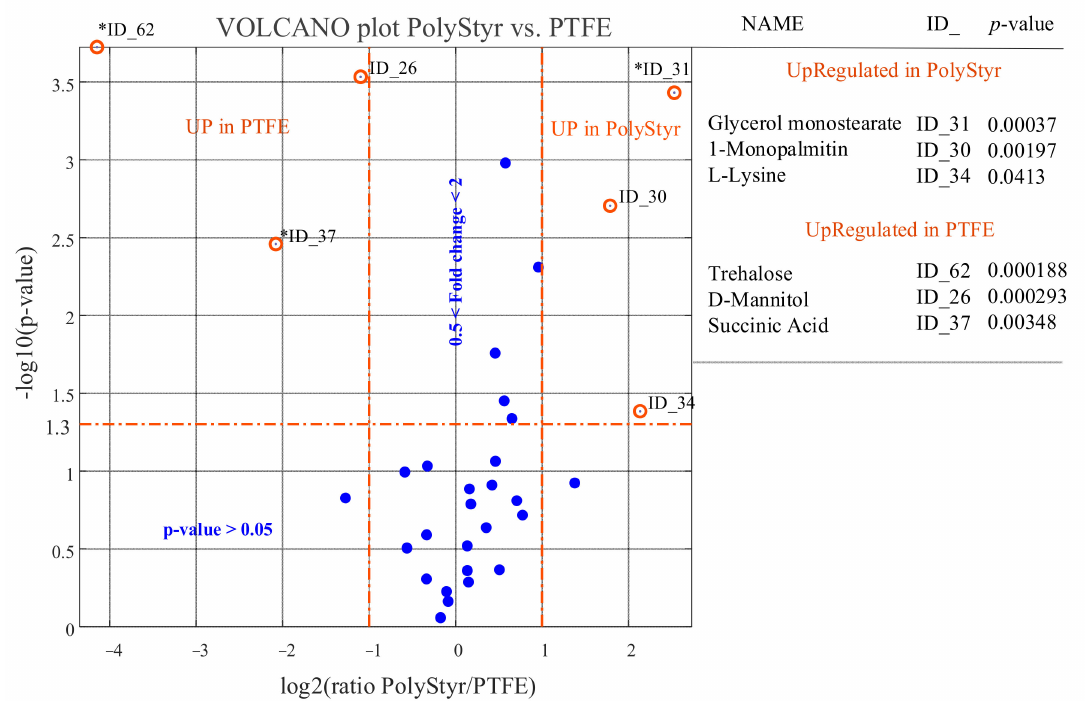
Figure 6. Results of univariate comparison of polystyrene (PolyStyr class) vs. Teflon (PTFE class). For each metabolite, fold change (FC) is defined as the ratio between mean relative abundances in PolyStyr and PTFE classes. Only metabolites with p value < 0.05 and fold changes greater than 2 are considered upregulated in the PolyStyr class, and only metabolites with p value < 0.05 and fold changes lower than 0.5 are considered upregulated in PTFE class (orange rings). Blue dots represent metabolites with no significantly different levels in the two compared classes. Fold change of metabolites marked with an asterisk (*) has been evaluated by the data imputation strategy described in the text. Metabolites can be tracked back to identified metabolites in Table 1 through the ID_##